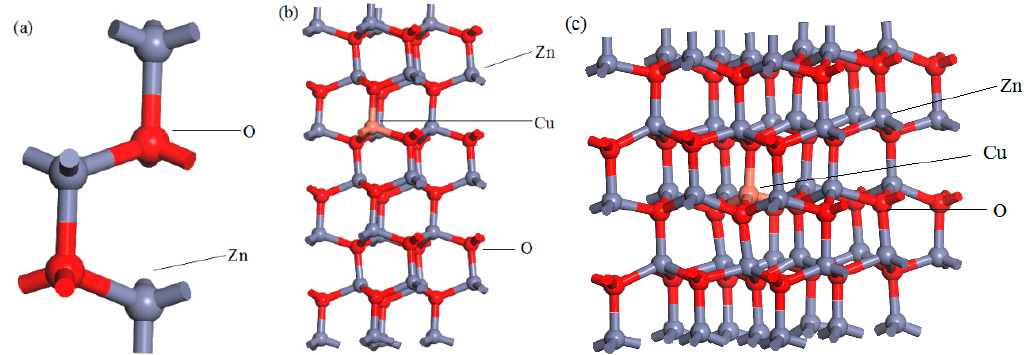
Figure 1. The models of: ( a ) pure ZnO, ( b ) Cu 0.0417 Zn 0.9583 O supercell, ( c ) Cu 0.0278 Zn 0.9722 O supercell.